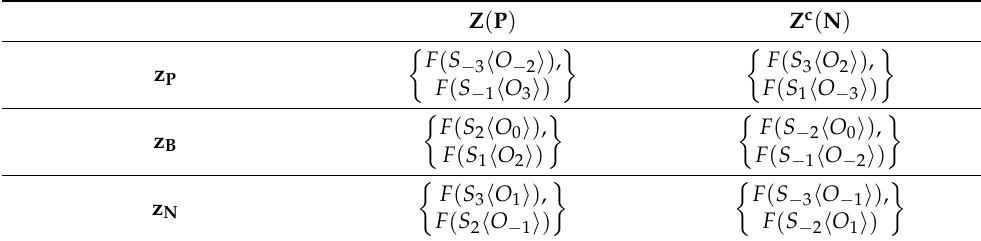
Table 5. Information on the loss function with DHHLT.